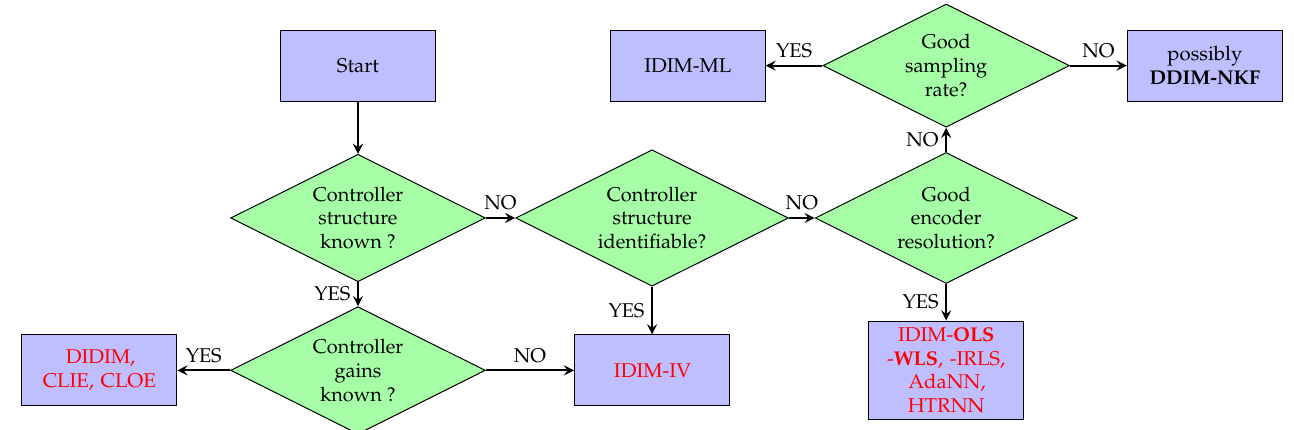
Figure 11. Decision process for parameter identification algorithm selection. Physical consistency of the estimates can be enforced using SDP within the algorithms displayed in red. Methods in bold caption are, or can potentially be formulated in a recursive manner which makes them capable of running in a real-time control